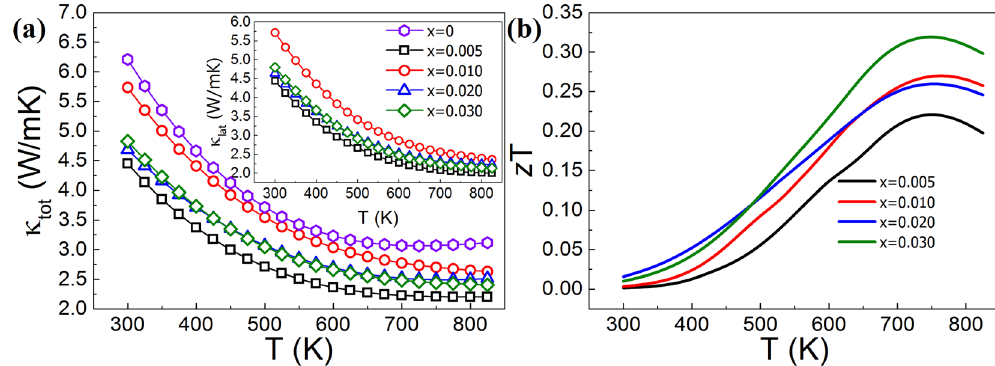
Figure 4. The temperature dependence of ( a ) the total thermal conductivity (inset: the lattice thermal conductivity) and ( b ) the figure-of-merit, z T, of the Mg 2 Ge 1 − x Bi x ( x = 0.005, 0.010, 0.020, 0.030) samples. Sample x = 0.005 exhibited a relative mass density of 86%, much lower than the 97% of all other samples, leading to a reduced κ tot